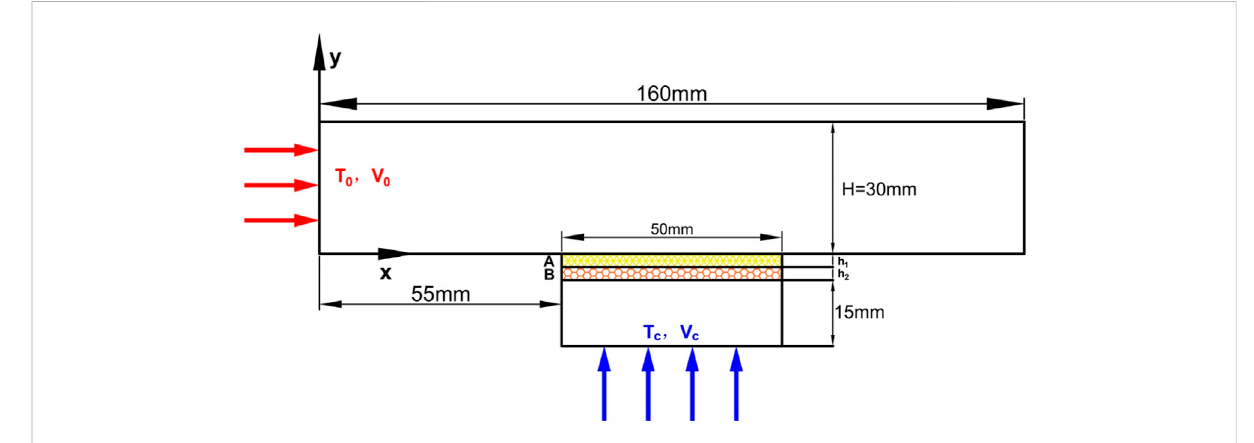
FIGURE 2 Model and coordinates for double-layer sintered porous